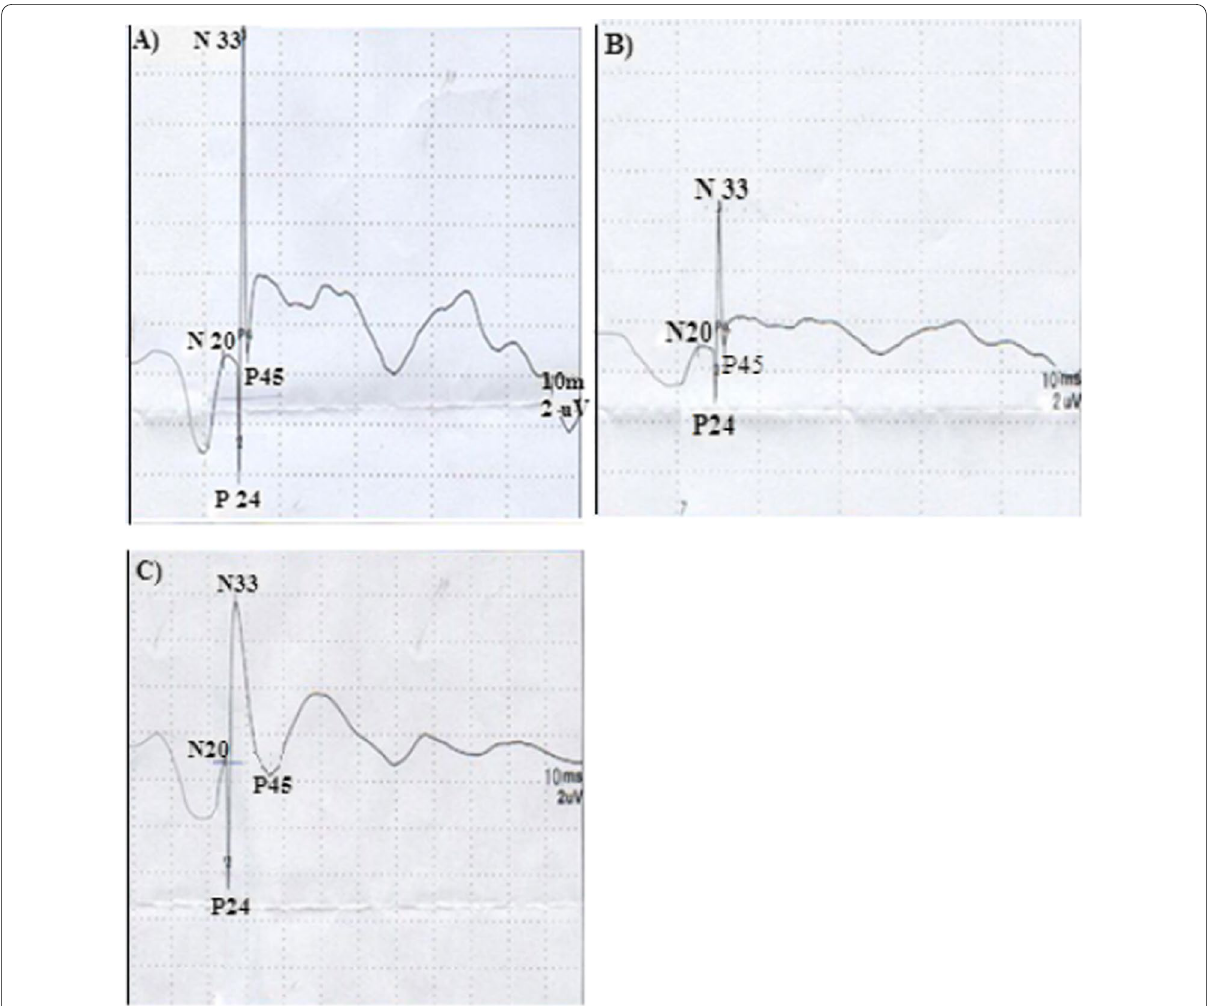
Fig. 1 EEG and SSEP in patients with different types of myoclonus. A SSEP in a patient with cortical myoclonus in case of PME showing giant response. B SSEP in a patient with cortical–subcortical myoclonus in case of JME showed no giant response in comparison with PME. C SSEP in a patient with subcortical myoclonus in case of secondary hepatic myoclonus showed giant response but of less values than